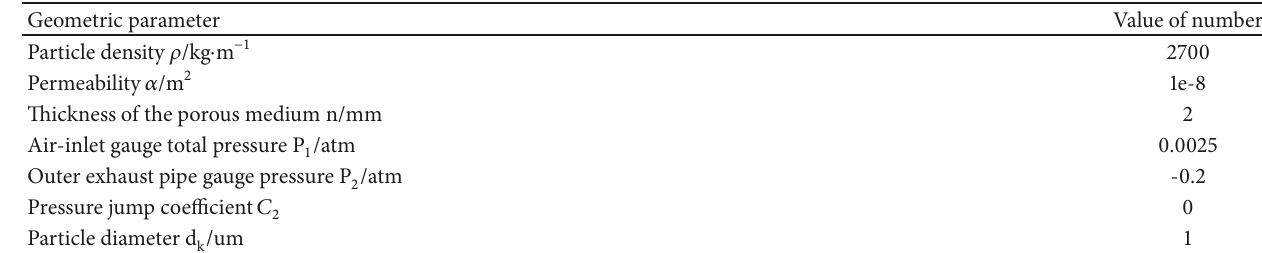
Table 2: Basic parameters of model